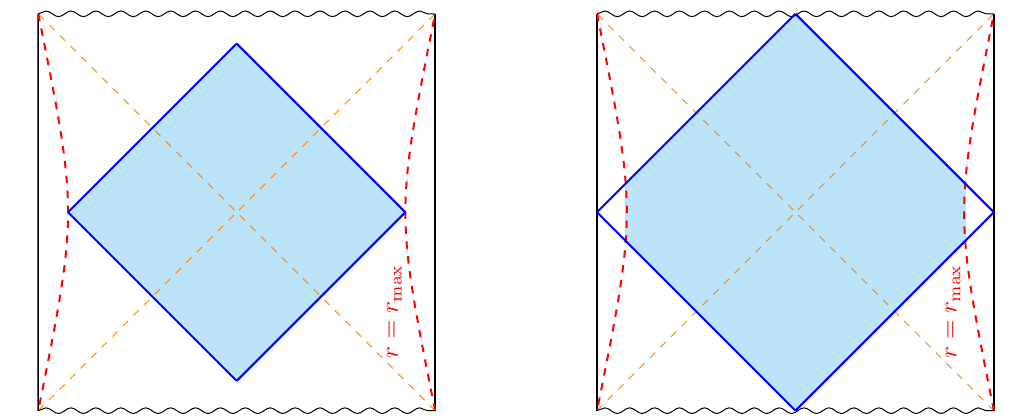
Figure 2 . WDW patches for a two-sided AdS black hole in two di(cid:11)erent regularizations: left) the (cid:12)rst regularization in which the null boundaries of the WDW patch start at r = r max . Right) the second regularization, in which the null boundaries start at the true boundary of the bulk spacetime at r = . Note that in the second regularization, the WDW patch has two extra timelike boundaries 1 at r = r max